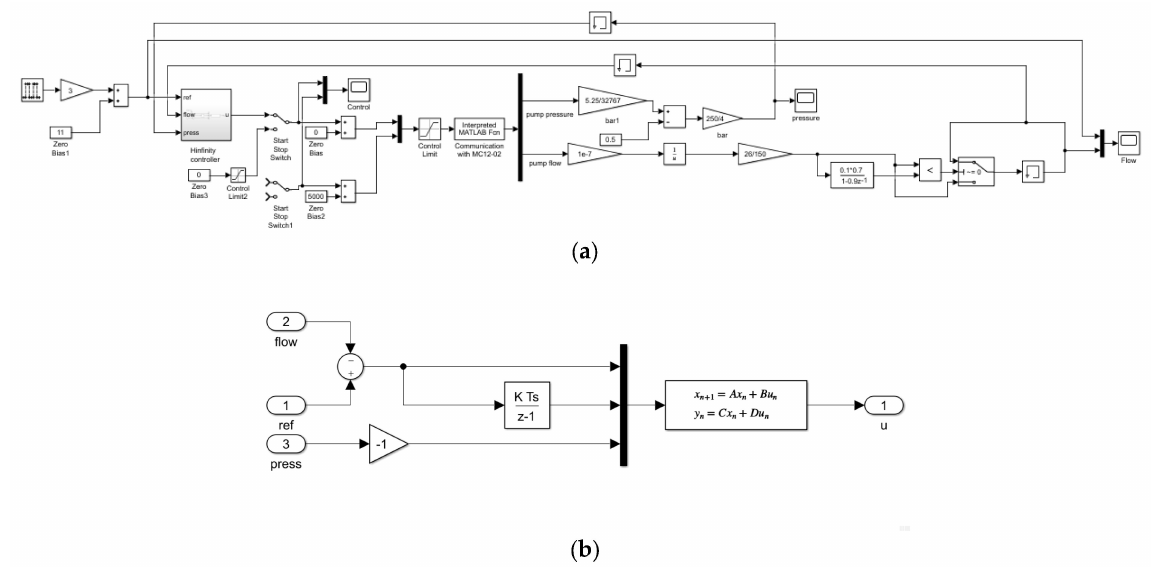
Figure 13. ( a ) Simulink implementation of the host controller. ( b ) Simulink implementation of the host